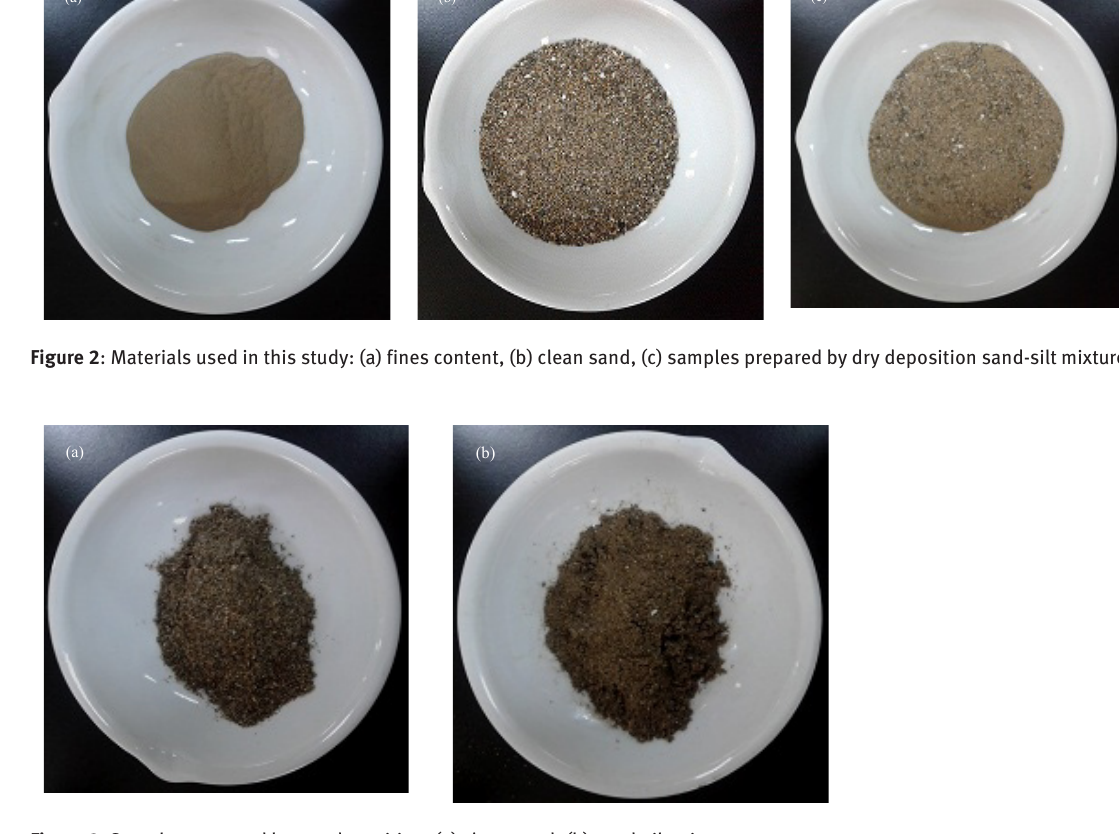
Figure 3: Samples prepared by wet deposition: (a) clean sand, (b) sand-silt